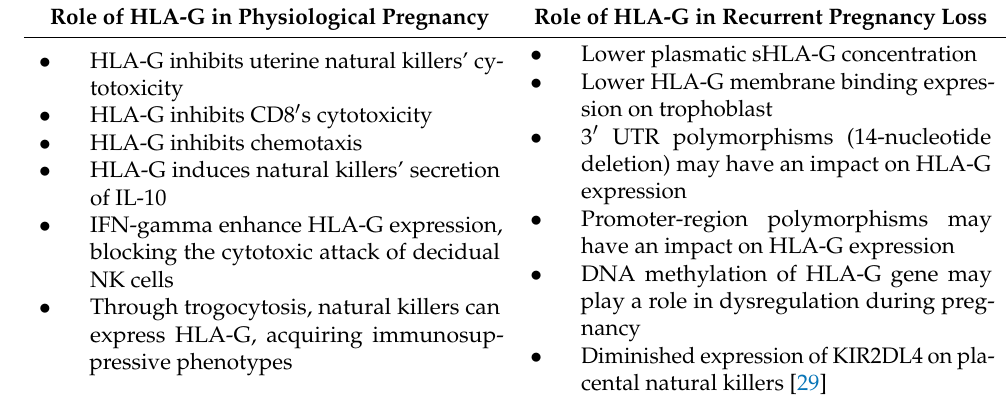
Table 1. Human Leukocyte Antigen-G (HLA-G)’s roles and mechanisms in physiological pregnancy and in recurrent pregnancy